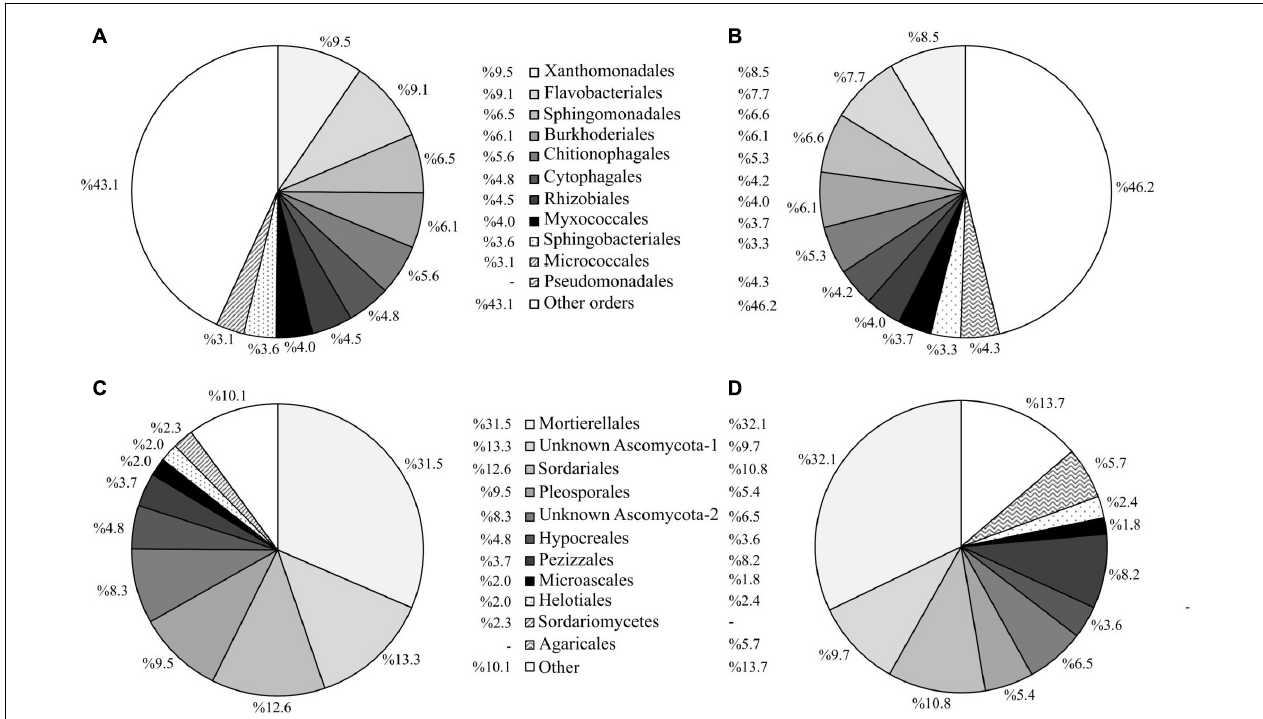
FIGURE 7 | Abundance profiles of the 10 most abundant prokaryotic and fungal taxa at order level for plots under the experimental factor “alfalfa sowing” at the end of the experiment. Abundance of prokaryotic taxa in plots with (A) and without (B) alfalfa. Abundance of fungal taxa in plots with (C) and without (D) alfalfa.